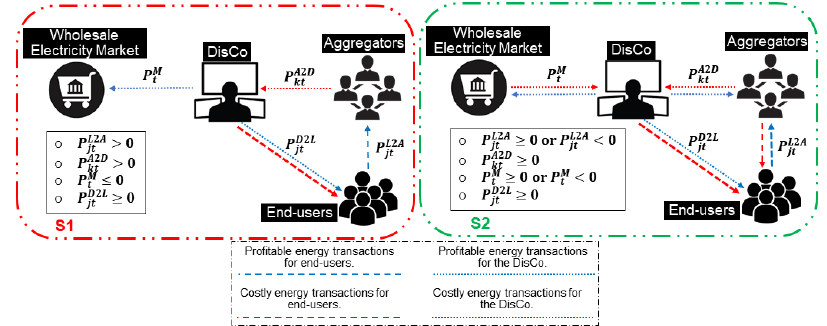
Figure 8. Energy trading flow between agents in the distribution network in Case 2 (proposed iterative